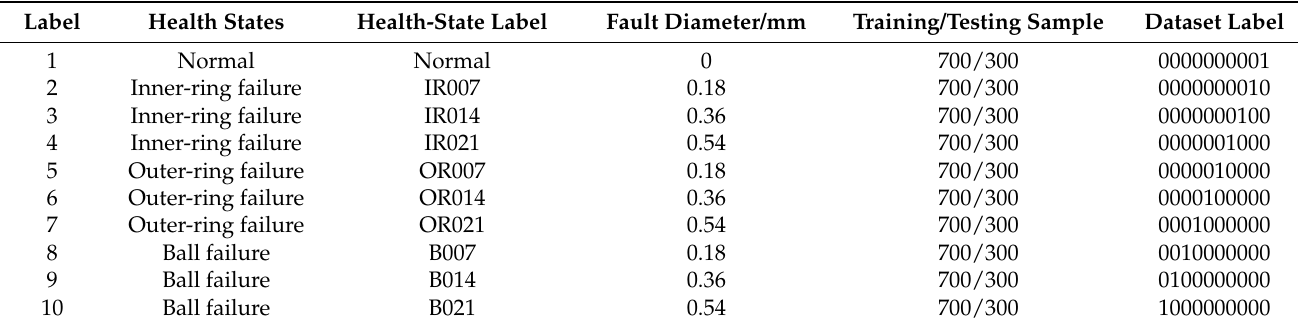
Table 1. Detailed information of the CWRU dataset.